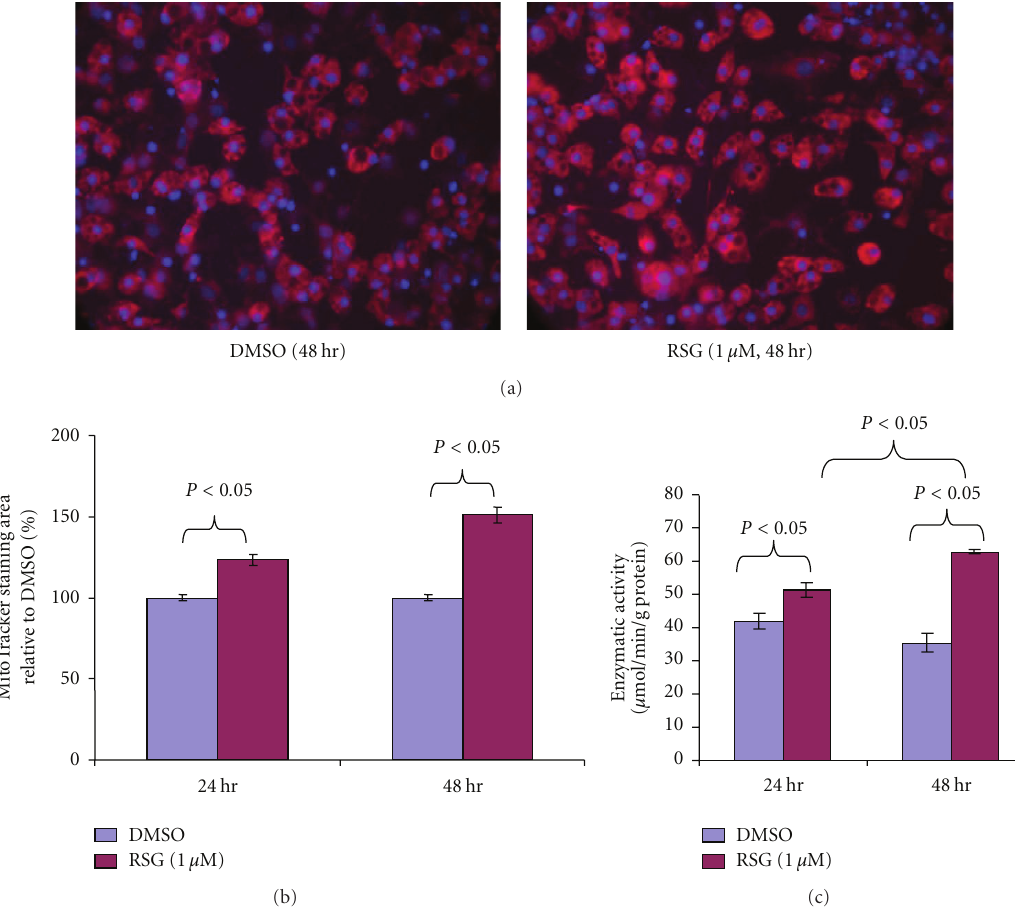
Figure 4: RSG increased mitochondrial staining and citrate synthase activity in 3T3-L1 adipocytes. (a) Representative pictures of 3T3-L1 adipocytes stained with Mito Tracker Red CMXRos (for mitochondria, red) and Hoechst (for nucleus, blue). Magnification = 400x. (b) Quantification of mitochondrial staining ( n = 8 each treatment). (c) Measurement of citrate synthase activity ( n = 2 each condition). All numerical data were expressed as mean ± S.E. All experiments were repeated at least